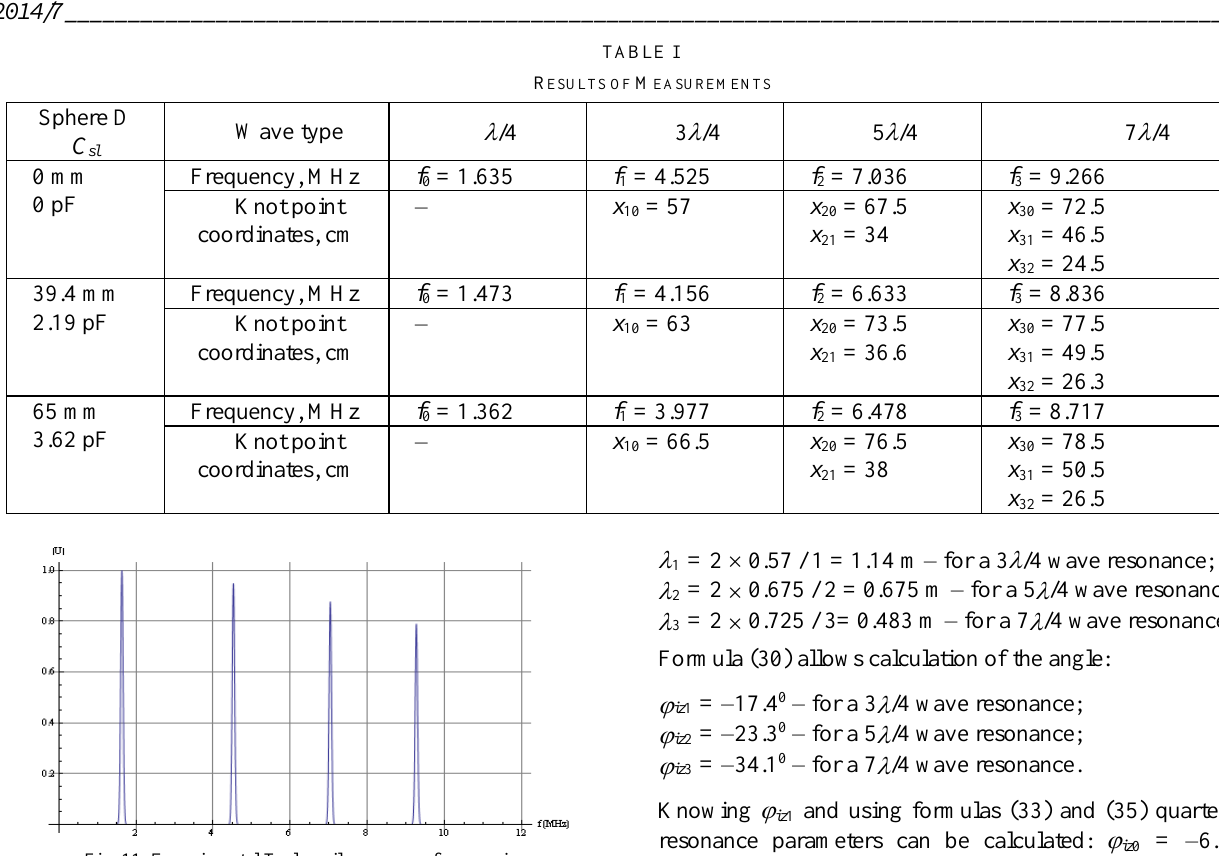
Fig. 11. Experimental Tesla coil resonance